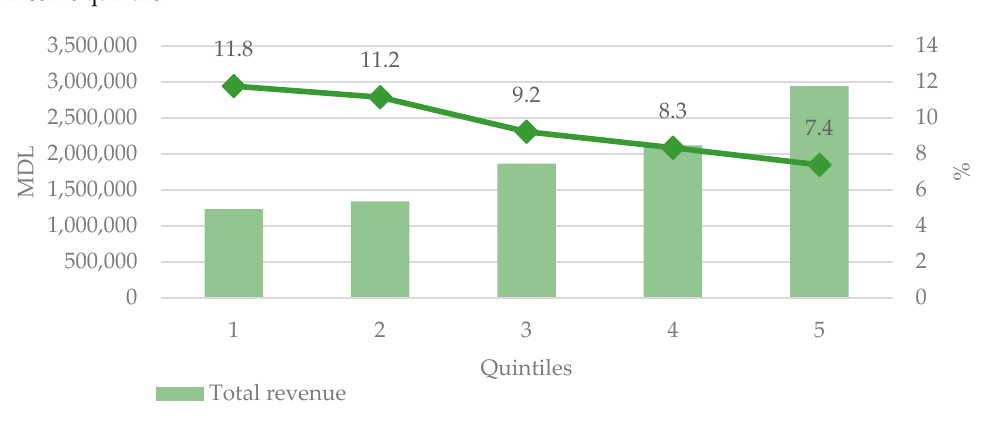
Figure 7. Forest dependence (products collected and products purchased) of households in sampled villages by wealth quintile.